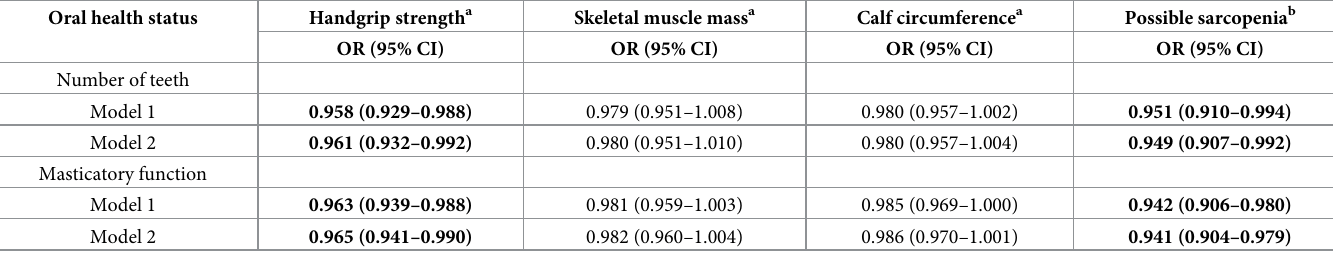
Each sarcopenia outcome was analyzed with oral health using the logistic regression after adjusting for sex, age, body mass index, smoking, alcohol consumption, and